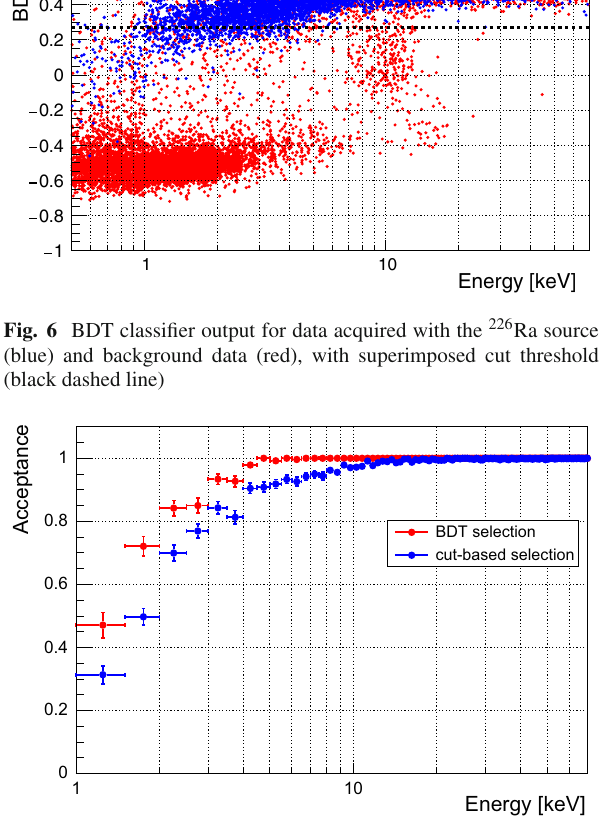
Fig. 7 AcceptanceasafunctionoftheenergyforthemultivariateBDT analysis and, as a comparison, for the cut-based approach